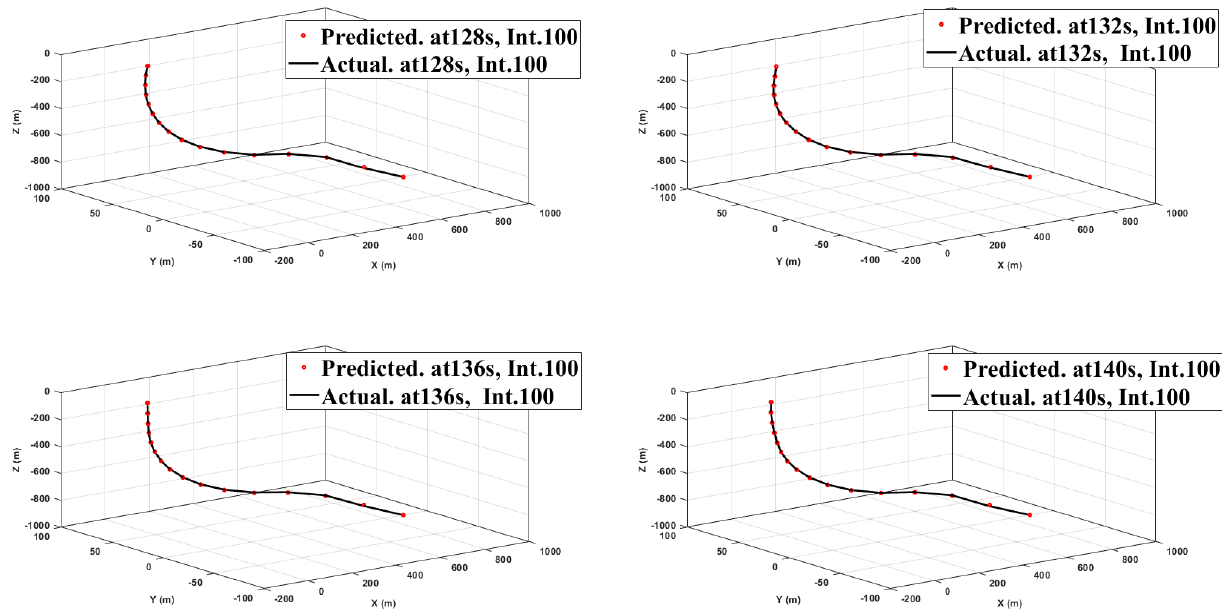
Figure A2. Node Displacement Tracing, Snapshots, 100-yr storm, WD1000, SLWR, Entire Arc Length.